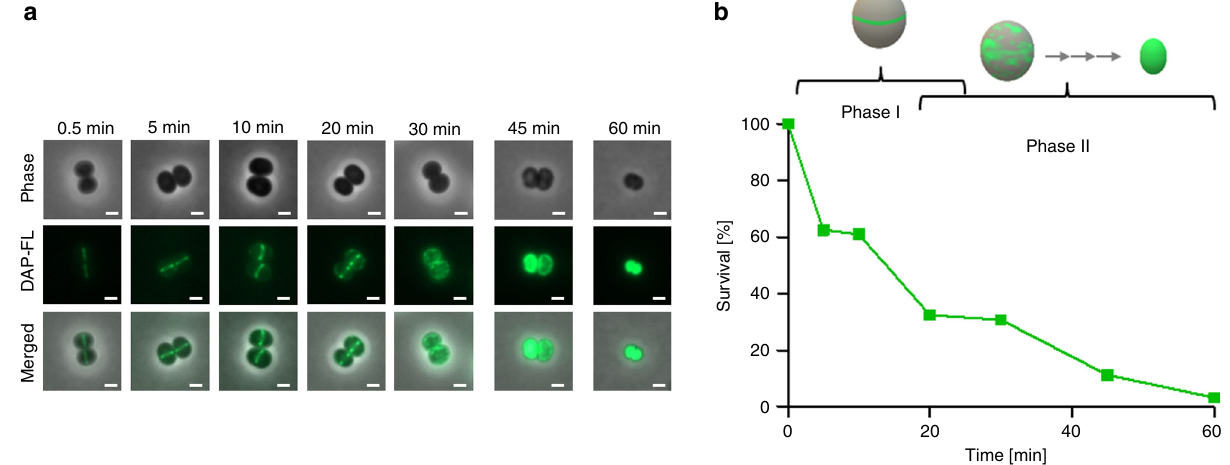
Fig. 2 DAP binds to S. aureus in a biphasic manner. a DAP-FL binding to S. aureus monitored over time (0 – 60 min). S. aureus HG003 was grown to mid- exponential phase (OD 600 = 0.5) followed by the addition of Ca 2 + and a mixture of labelled and unlabelled DAP (7 µ g ml − 1 DAP; 0.8 µ g ml − 1 DAP-FL). At different time points, samples were taken, washed and imaged by fl uorescence microscopy. Representative pictures are shown from three independent experiments. Phase, phase contrast. Scale bar 1 µ m. b Survival of cells from the experiment described in a and schematic depiction of DAP-FL-binding behaviour in two phases. Source data are provided as a Source Data fi